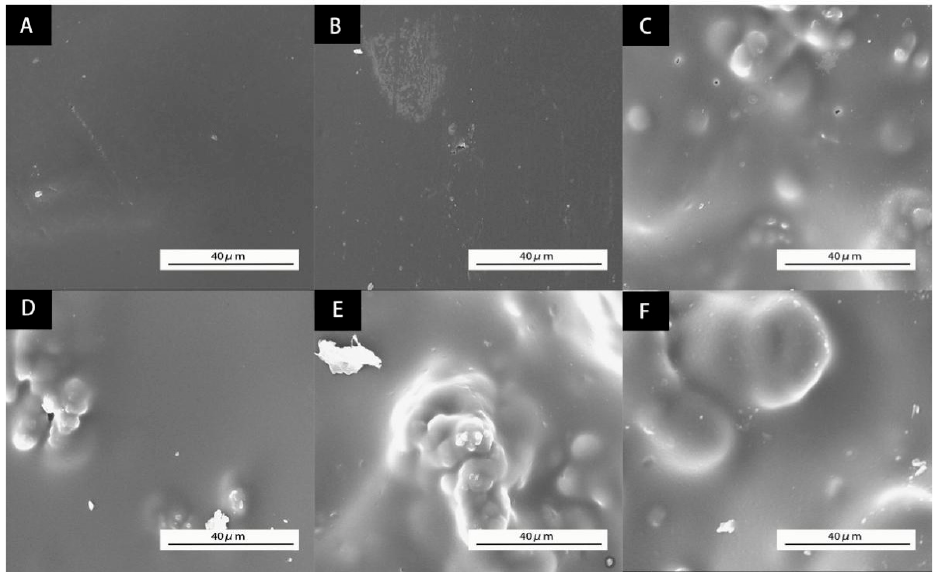
Figure 9. SEM of waterborne coatings with different contents of microcapsules (rice husk powder content 5.5%): ( A ) 0%; ( B ) 3%; ( C ) 6%; ( D ) 9%; ( E ) 12%; ( F ) 15%. The microcapsules with rice husk powder content of 5.5% and the waterborne primer